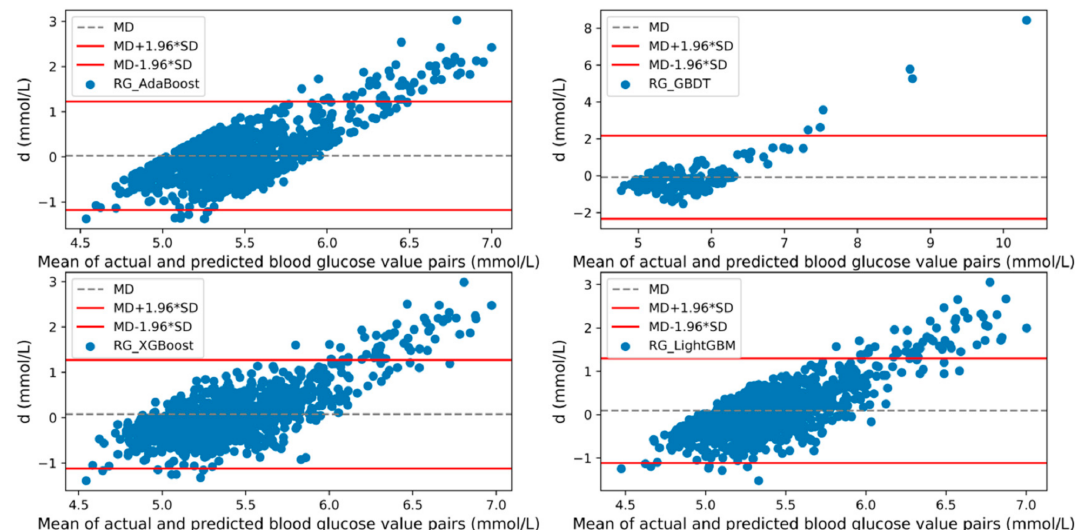
Figure 8. The Bland–Altman plots for the RG-enriched models. The scatter plots and Clarke error grid analysis (EGA) diagrams of the actual blood glucose levels versus the levels predicted by the four RG-enriched models are depicted in Figures 9–17. As evident from the EGA diagrams, for all RG-enriched models, a dominant part of values is in Zone A representing accurate blood glucose prediction results, some other values are in Zone B representing acceptable prediction results, and only a small percentage of values are in Zone D representing failure to detect and treat diabetes [48].